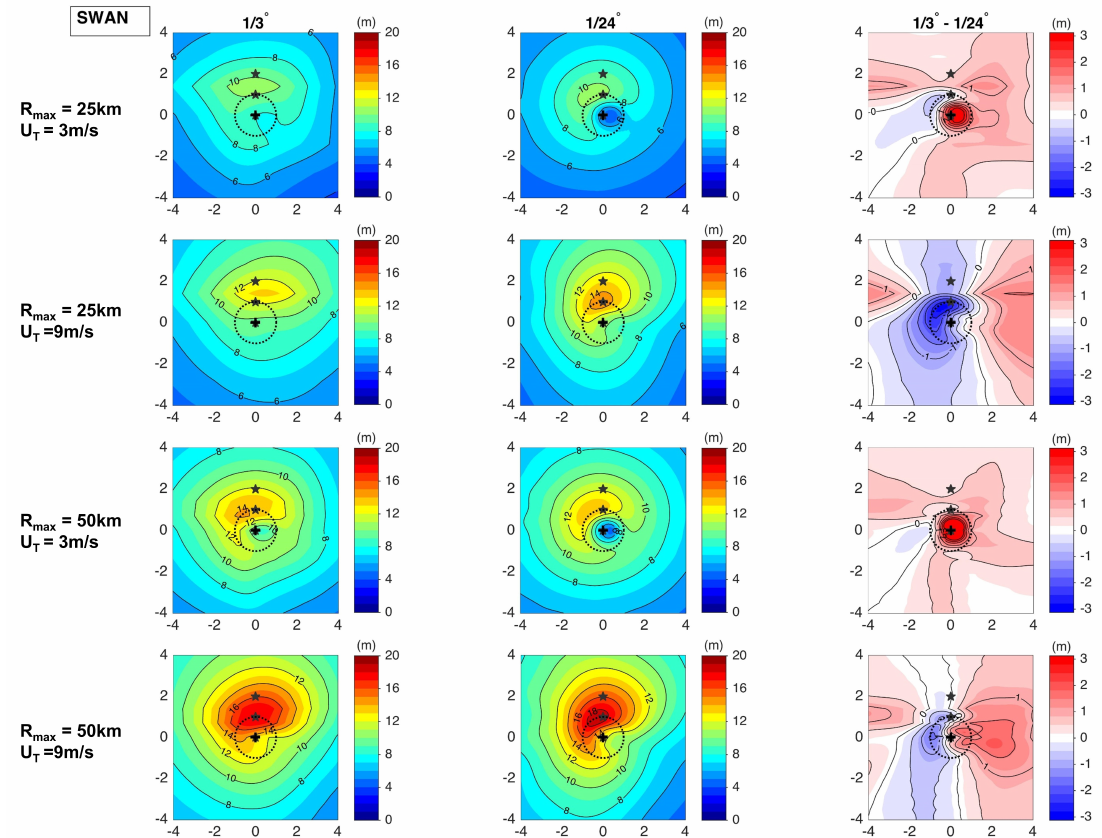
Figure 6. Spatial distribution of SWH in time-averaged quasi-steady state wave fields from SWAN. The results computed: at 1/3 ◦ resolution ( left ); and at 1/24 ◦ resolution ( right ). The figure format is the same as in Figure